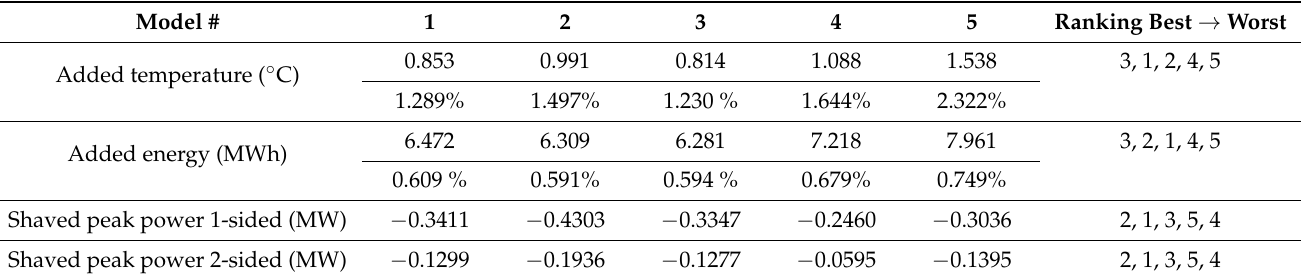
Table 3. KPI results for the simulation of the five